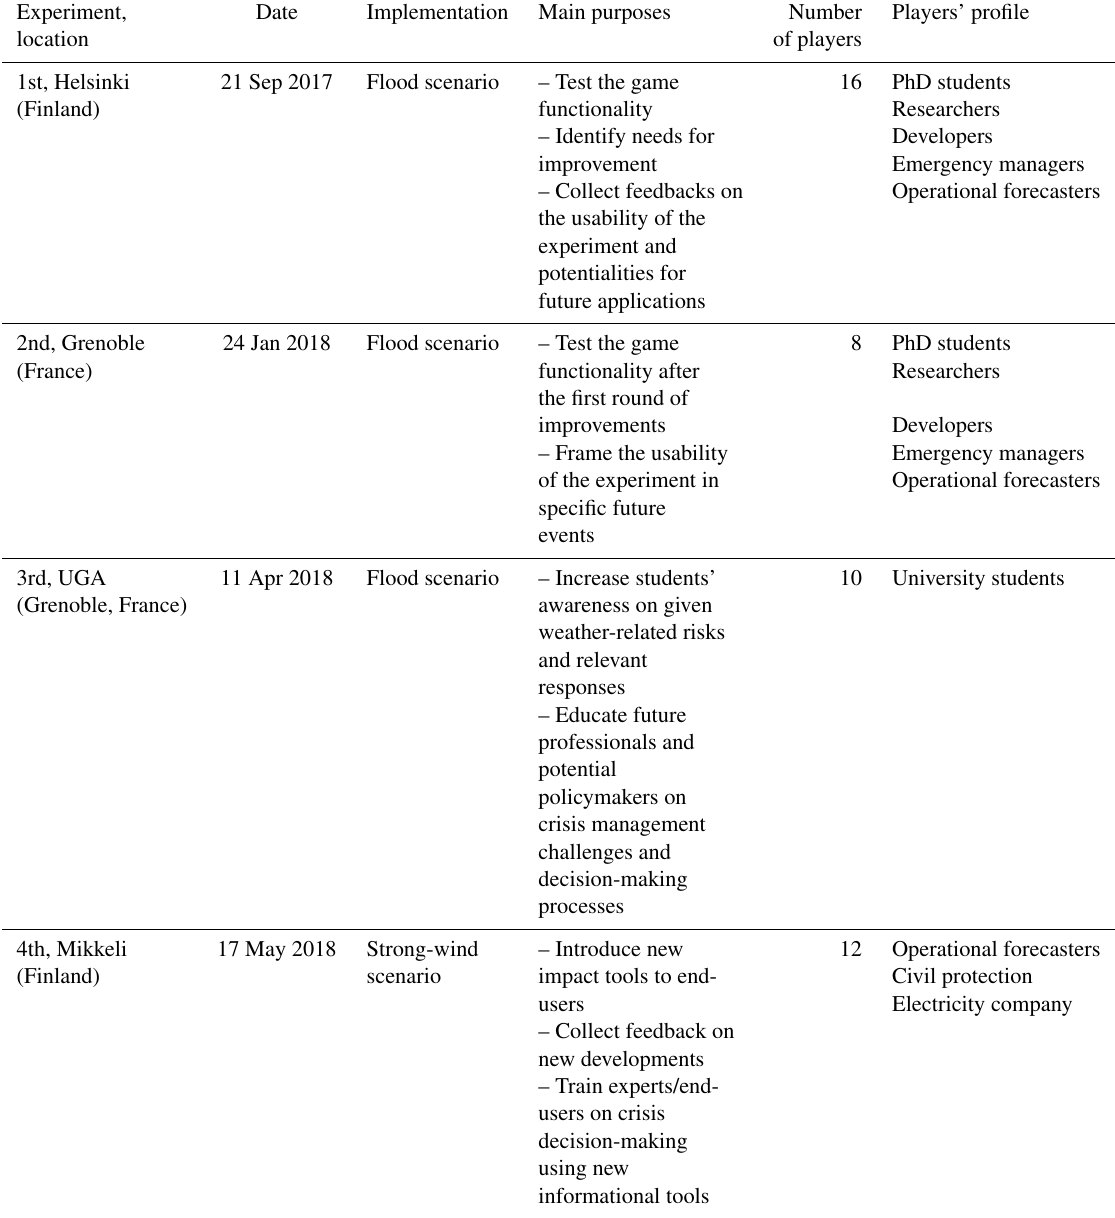
Table 3. Information for the game sessions conducted within ANYCaRE.